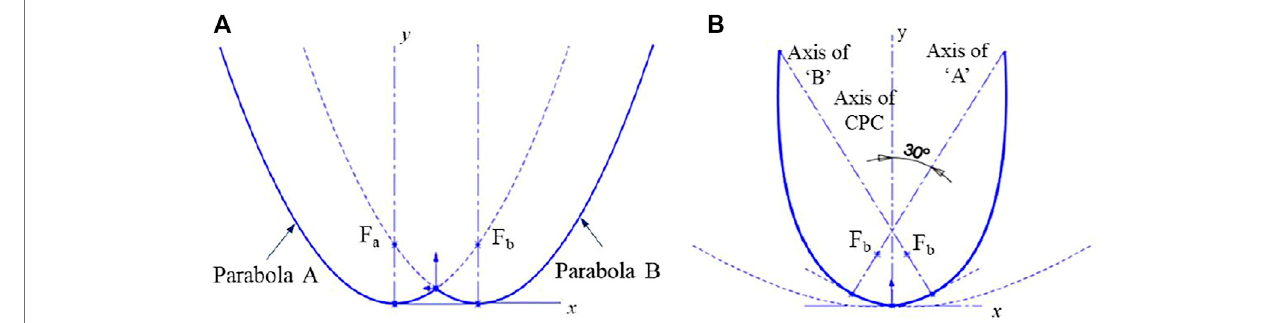
FIGURE 3 | Construction of a dual parabolic concentrator.